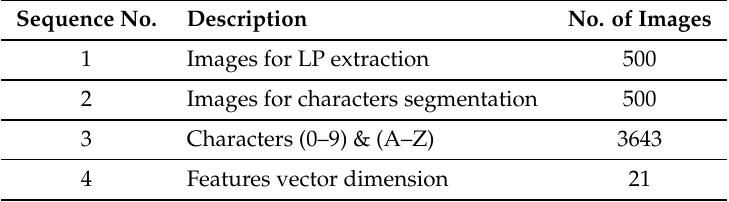
Table 2. Dataset description for LP extraction, characters segmentation and recognition.